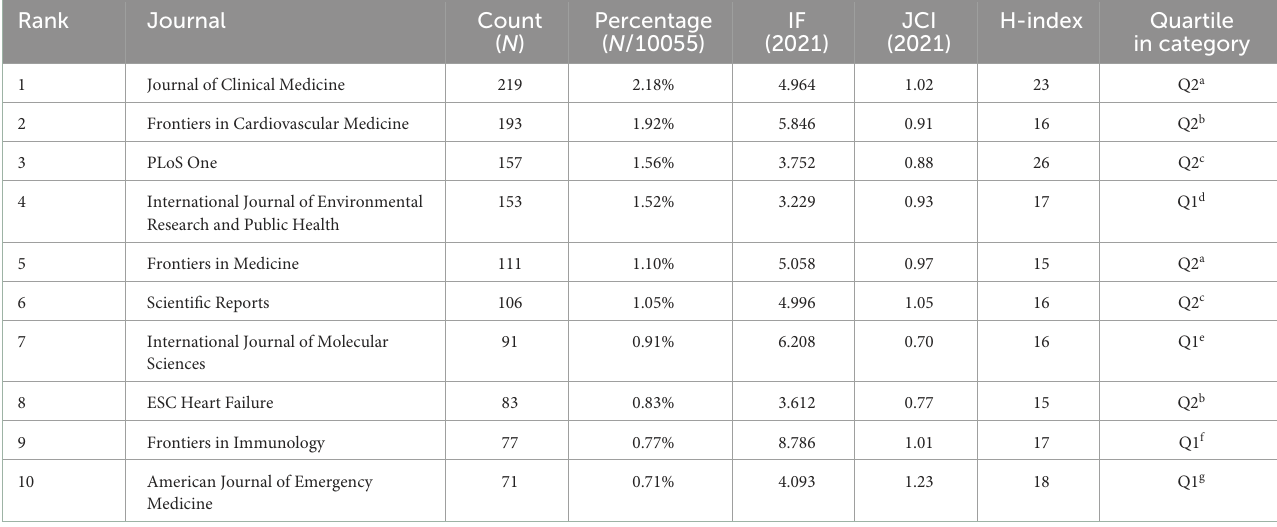
TABLE 3 Top 10 most productive journals related to CVDs and COVID-19.